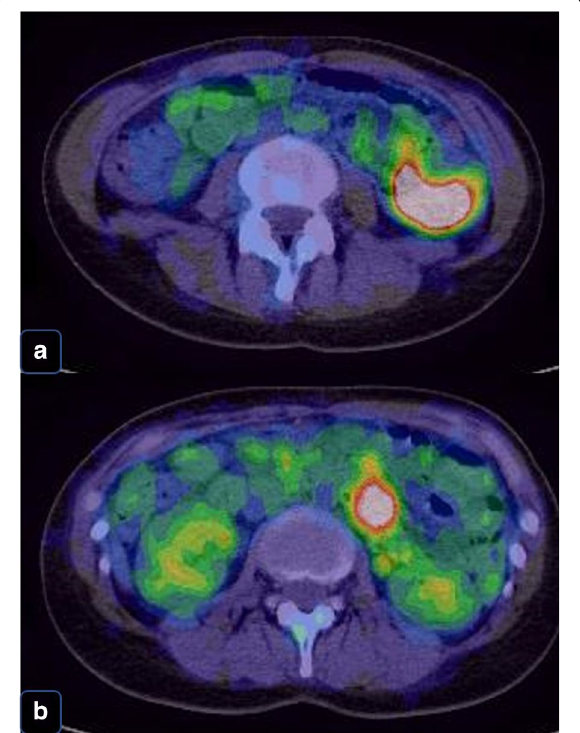
Fig. 3 PET–CT confirmed an abnormal accumulation of F-18 fluorodeoxyglucose in the tumor and lymph nodes. a Primary tumor’s accumulation. b Lymph nodule’s